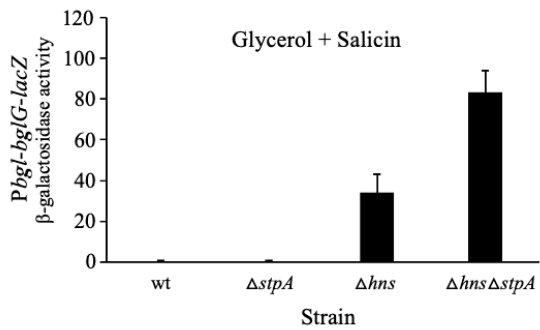
Figure 3. Inhibitory effect of StpA on bgl operon expression in the absence of H-NS. Using the operon reporter, P bgl - bglG - lacZ (at the lac locus), the bgl operon transcriptional activities were assayed, comparing the stpA single mutant ( ∆ stpA ), the hns single mutant ( ∆ hns ), and the hns / stpA double mutant ( ∆ hns ∆ stpA ). Cells were cultured in M63 with glycerol and salicin. Sample preparation and β -galactosidase assays were carried out as in Figure 1.